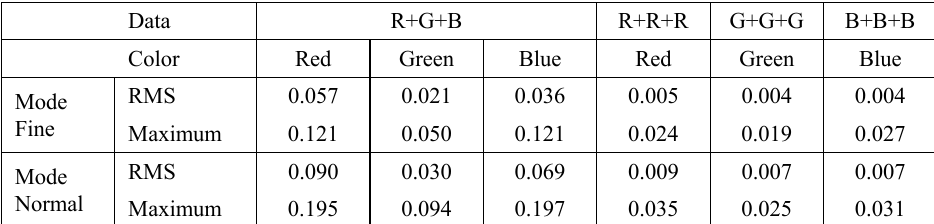
Table 3 indicates that the magnitude of the displacements caused by lossy JPEG compression was considerably smaller